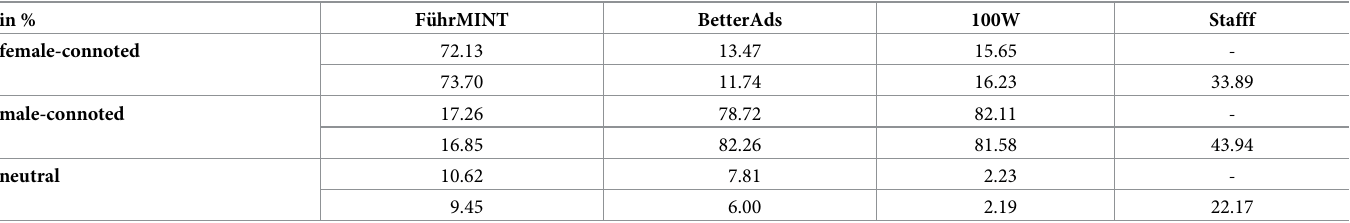
Table 3. Percentage of texts assigned to one of the three categories ‘female-connoted’, ‘male-connoted’ and ‘neutral’ by each of the tools. There are two rows per cate- gory: the first row represents all data ( n = 160, 246) while the second row represents data without Google Jobs ( n = 86, 132). in %